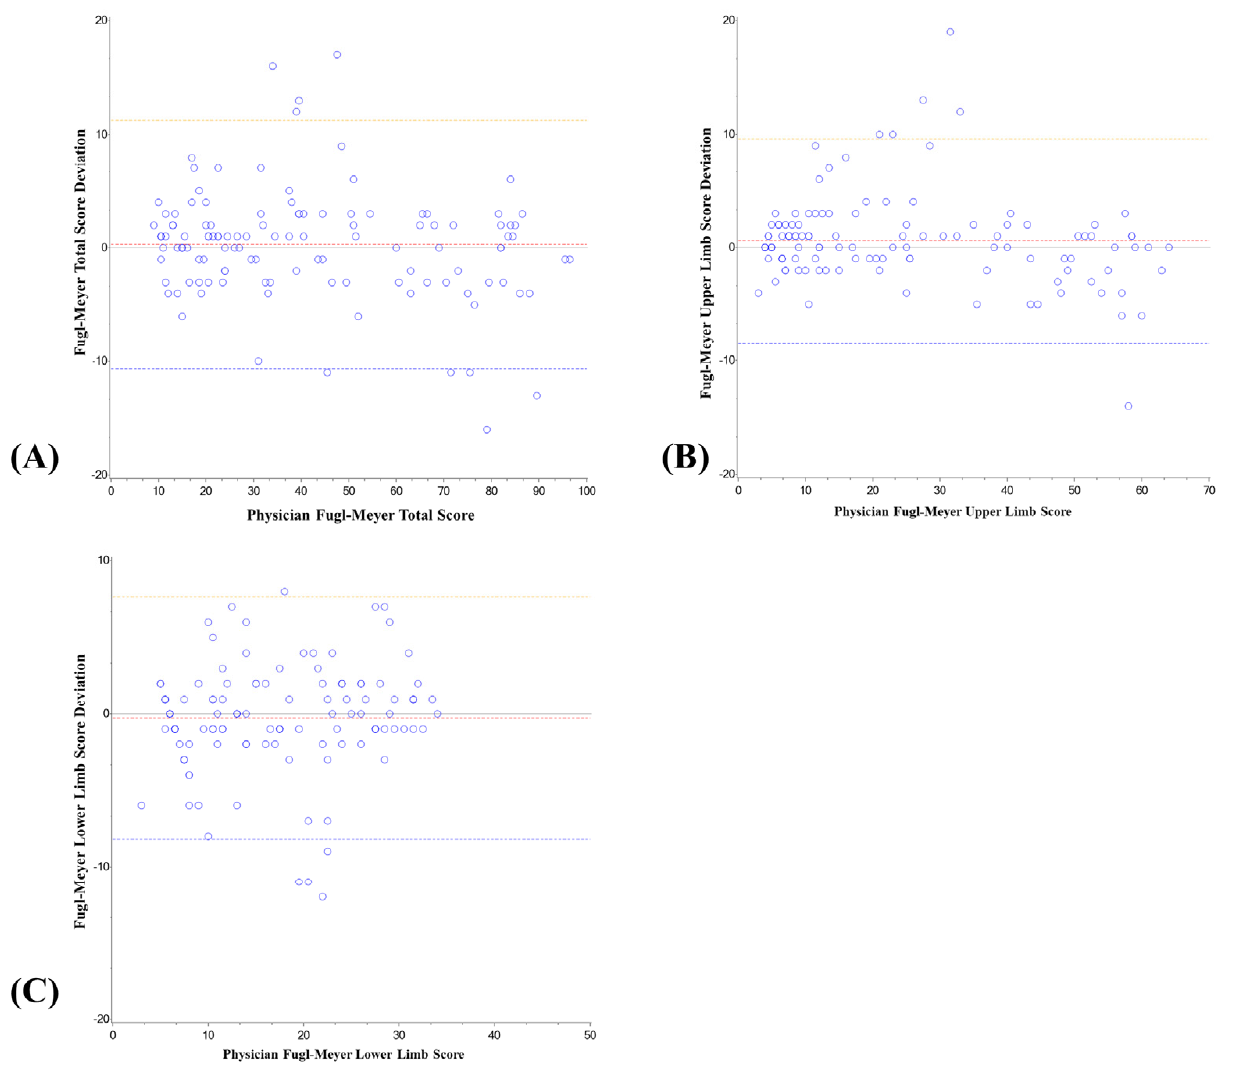
Figure 6. Intelligent rehabilitation system score and physician’s FMA score deviation analysis chart. Total score ( A ), upper − limb score ( B ), and lower − limb score ( C ) are the results of deviation between intelligent rehabilitation system score and physician’s FMA score.